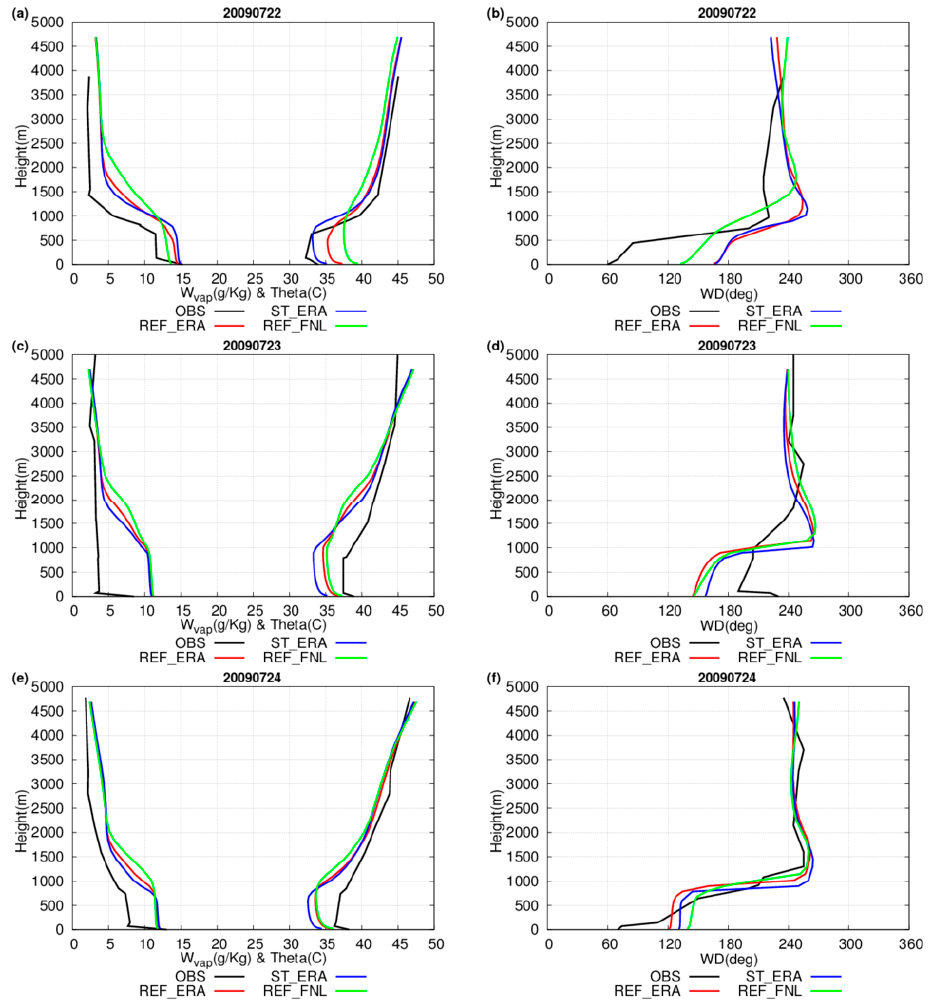
Figure 13. ( a – f ) Same as Figure 11, but at 12 UTC.